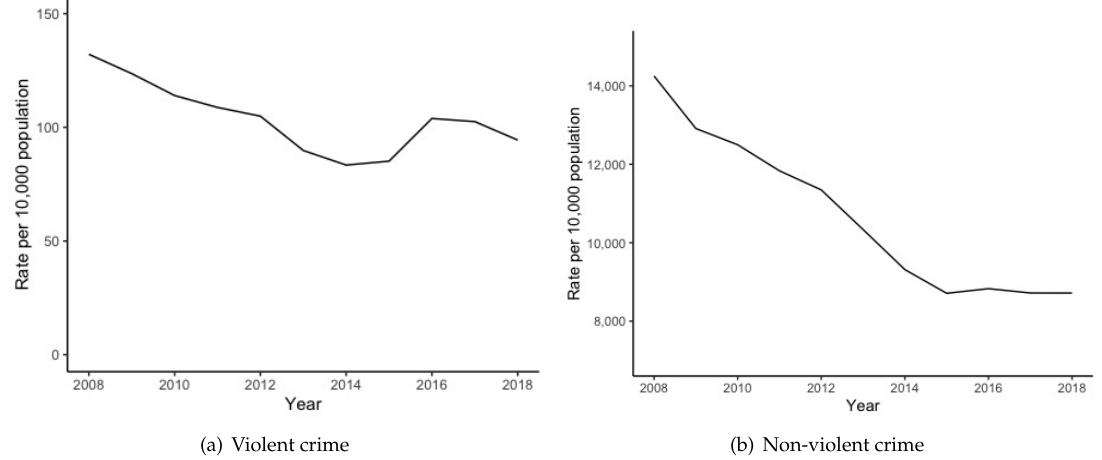
Figure 2: Violent and nonviolent crimes per 10,000 population in Chicago,